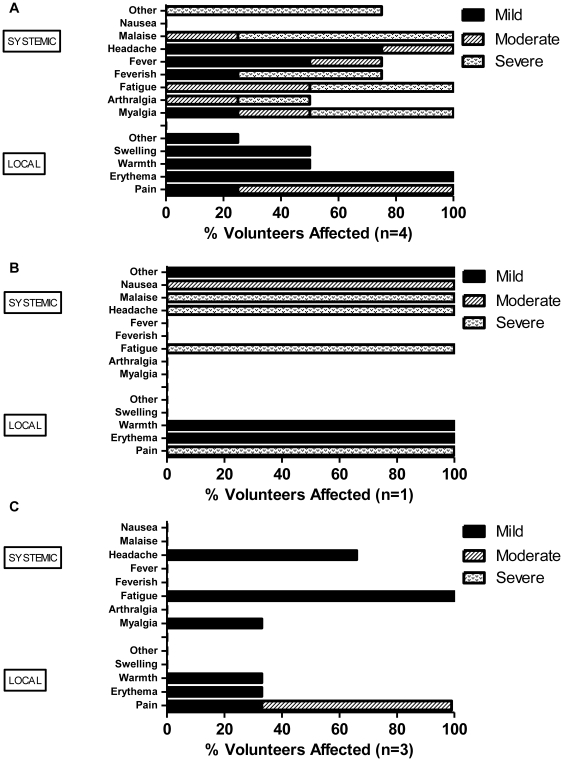
Local and systemic AEs deemed definitely, probably or possibly related to MVA AMA1.Only the highest intensity of each AE per subject is listed. Data are combined for all AEs for all volunteers receiving the same vaccine at the stated dose. There were no immunization related serious AEs. (A) Local and systemic AEs post 5×108 pfu MVA AMA1. Local ‘other’ AE was mild bruising at vaccination site. Systemic ‘other’ AEs included two cases of rigor, one case of delirium, loss of appetite and chills. (B) Local and systemic AEs post 2.5×108 pfu MVA AMA1. ‘Other’ AE post 2.5×108 pfu MVA AMA1 was dizziness. (C) Local and systemic AEs post 1.25×108 pfu MVA AMA1.